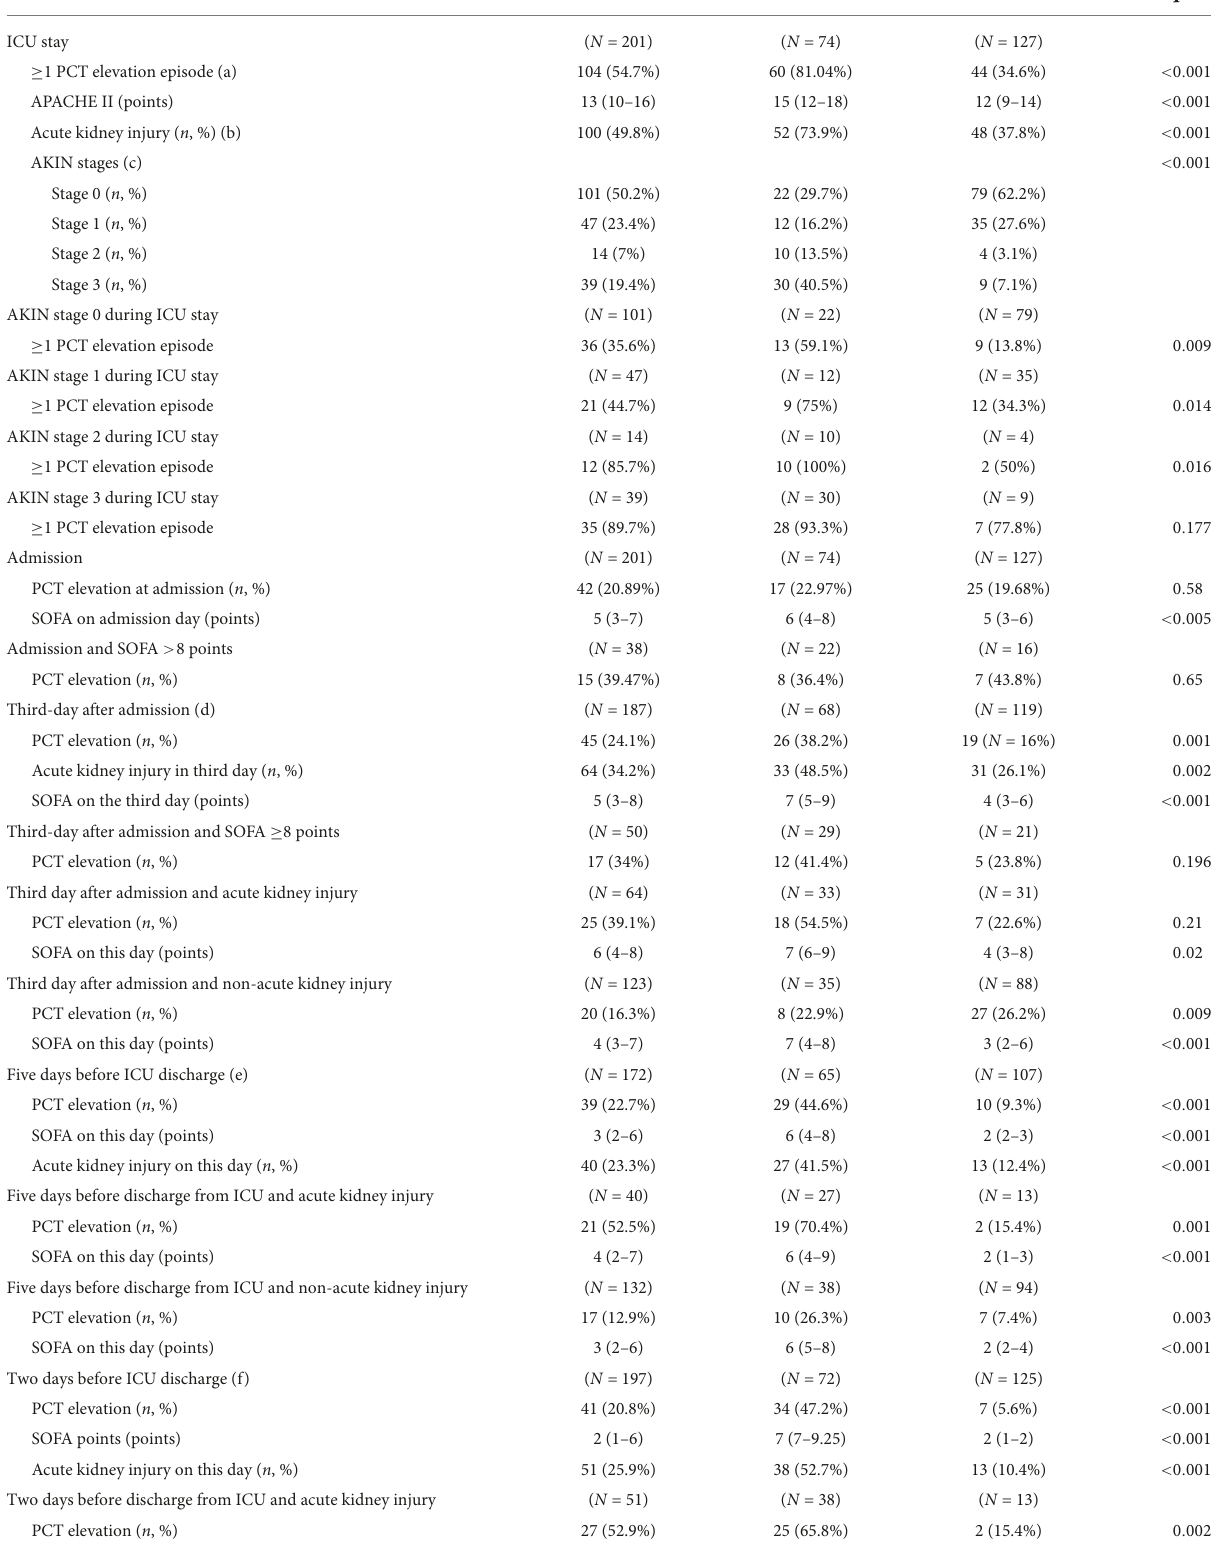
TABLE 2 Univariate analysis at different times of the ICU